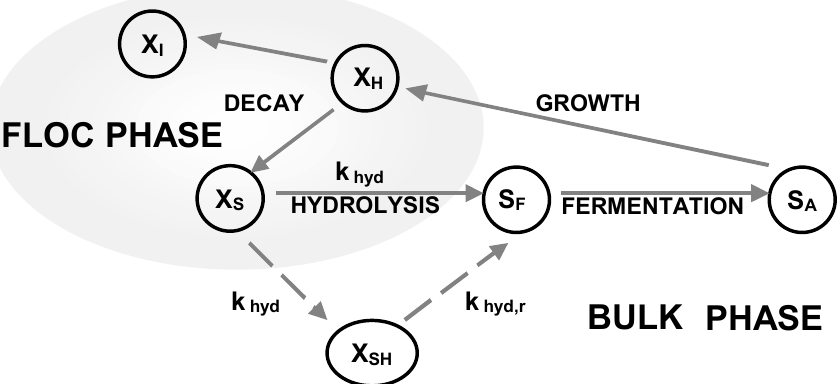
Figure 2. Scheme of the ASM2d, in continuous lines, and the modification proposed in the hydrolysis process, in dashed lines. X I : Inert particulate substrate; X H : Heterotrophic organisms; X S : Particulate substrate; X SH : Rapidly hydrolysable substrate; S F : Fermentable substrate; S A : Fermentation